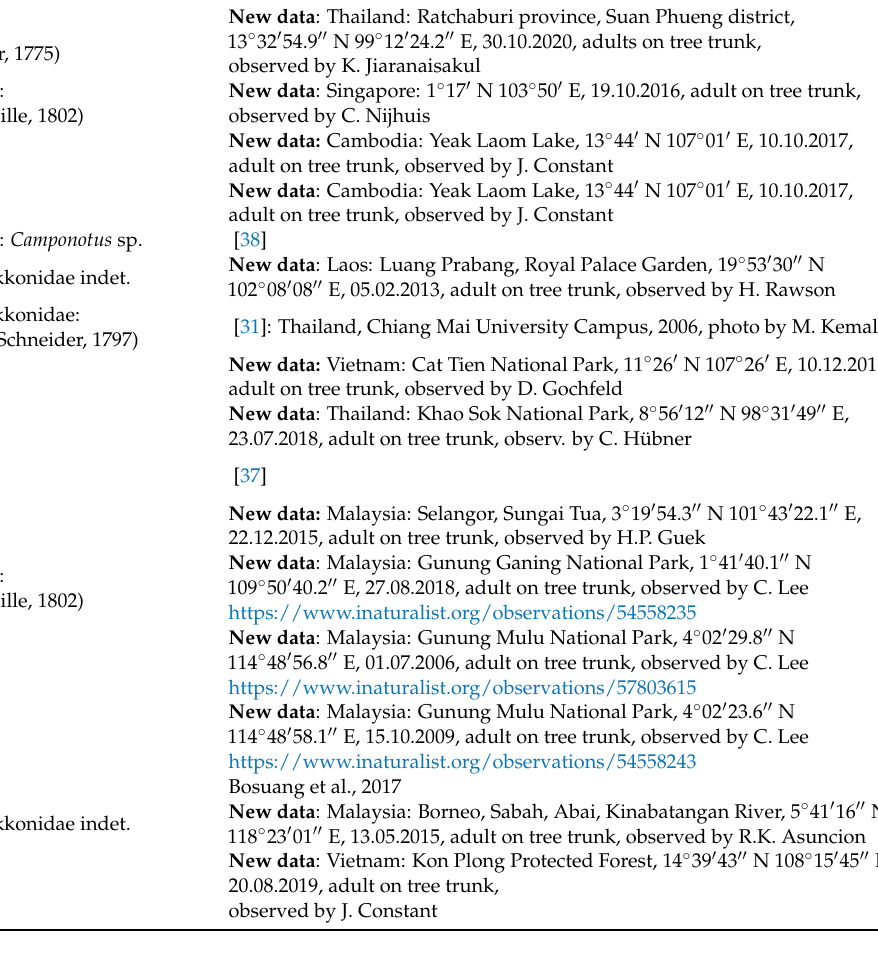
Figure 15d Polydictya thompsoni Constant and Pham, 2019 Figure 15e Polydictya sp. Figure 16a Polydictya sp. Figure 16b Polydictya sp.